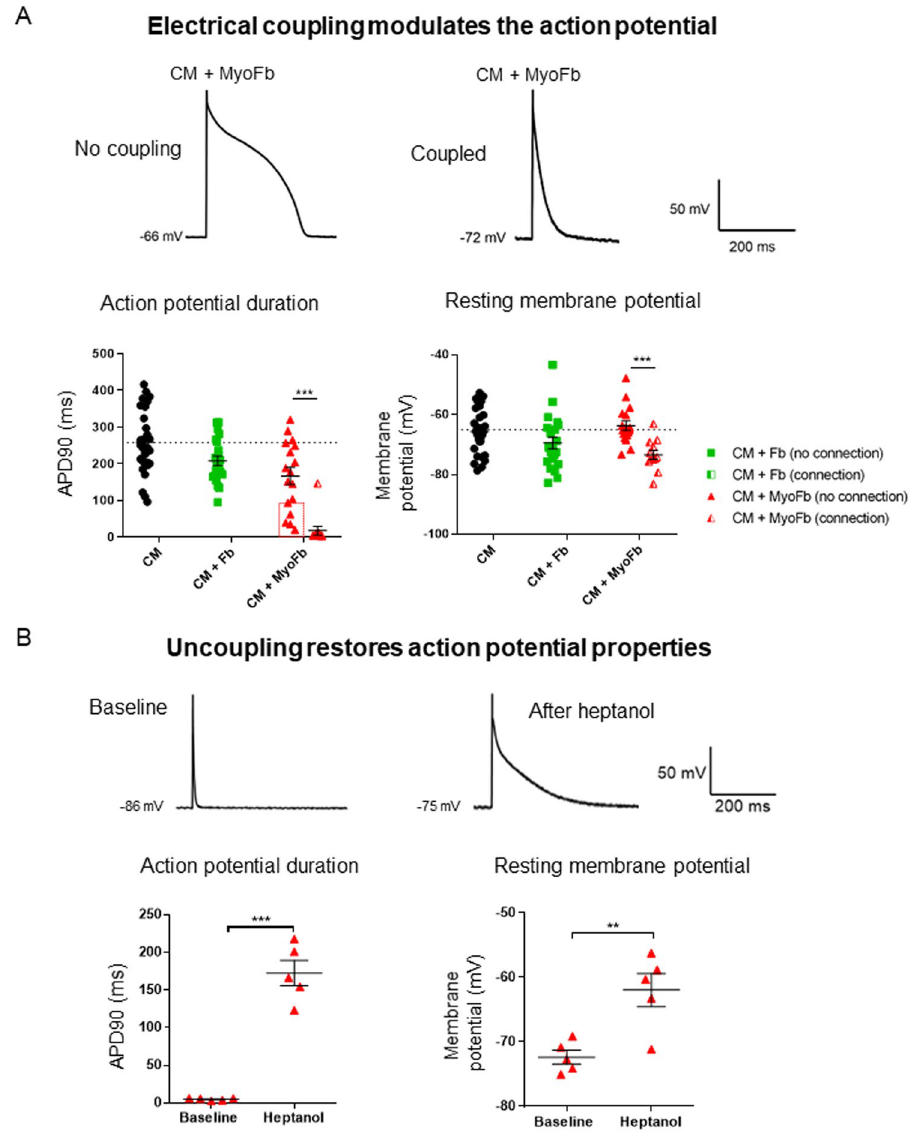
Figure 6. Electrical coupling to MyoFbs hyperpolarizes CMs and reduces action potential duration. ( A ) Examples of APs in CMs in direct co-culture with MyoFbs, with and without electrical coupling as determined by the capacitance test of Fig. 5. Mean data of ADP 90 and RMP for different co-culture conditions at day 1 (n cells = 12–30; N culture = 5; 2-way ANOVA with Bonferroni post hoc test, *** p = 0.0002). ( B ) Examples of AP in CMs before and after heptanol and with functional coupling to MyoFb. Mean data of APD 90 and RMP of CMs before and after heptanol and with functional coupling to MyoFb (n cells = 5, a subset of data in panel A; paired two-tailed Student t-test, ** p = 0.008, *** p =